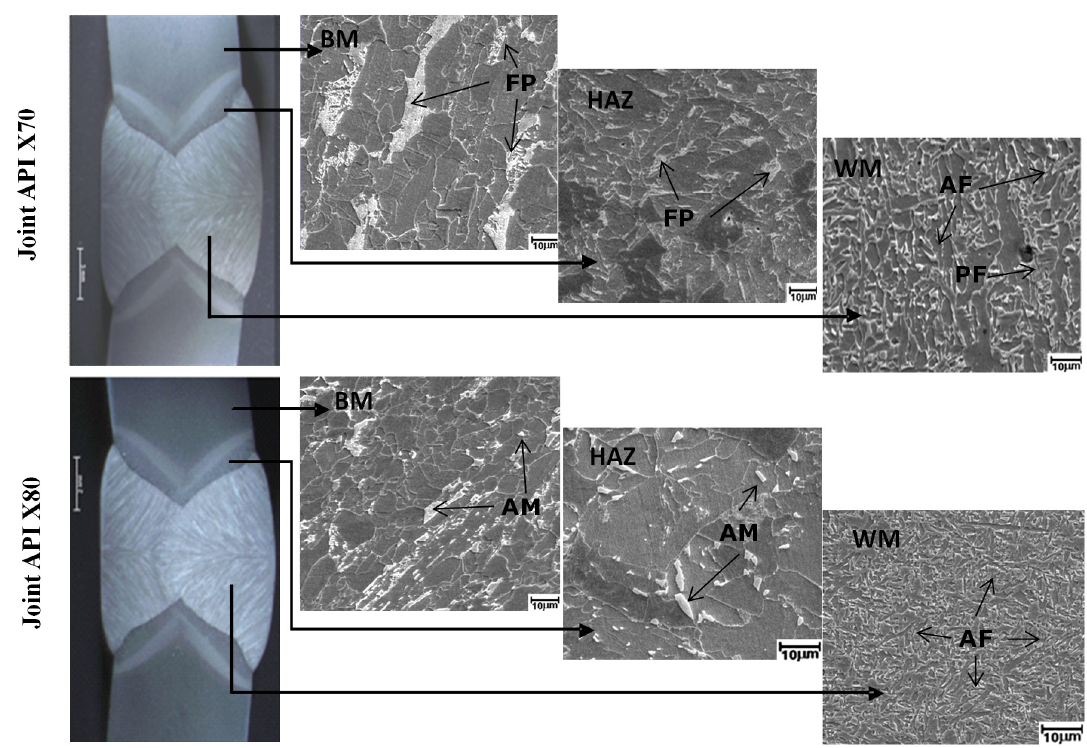
Figure 1. Representative microstructures of base metal, HAZ and weld metal.